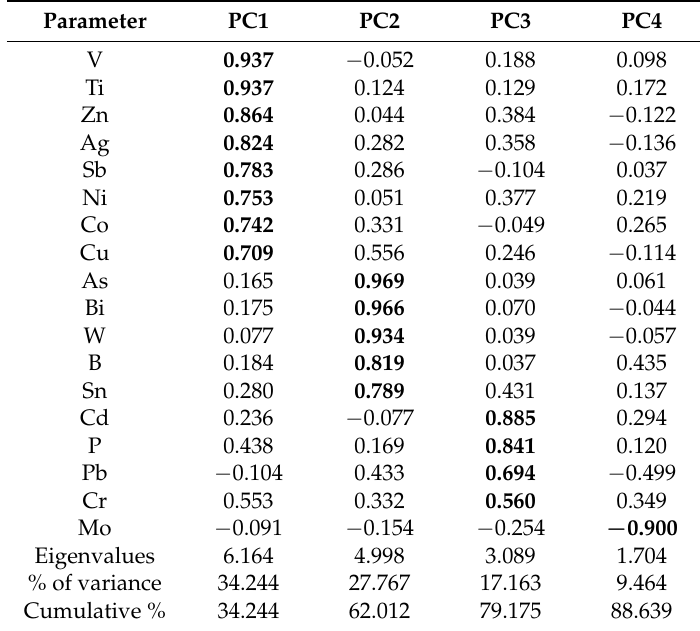
Table 4. Principal component loading (varimax normalization) for metals of top soils in the study area.